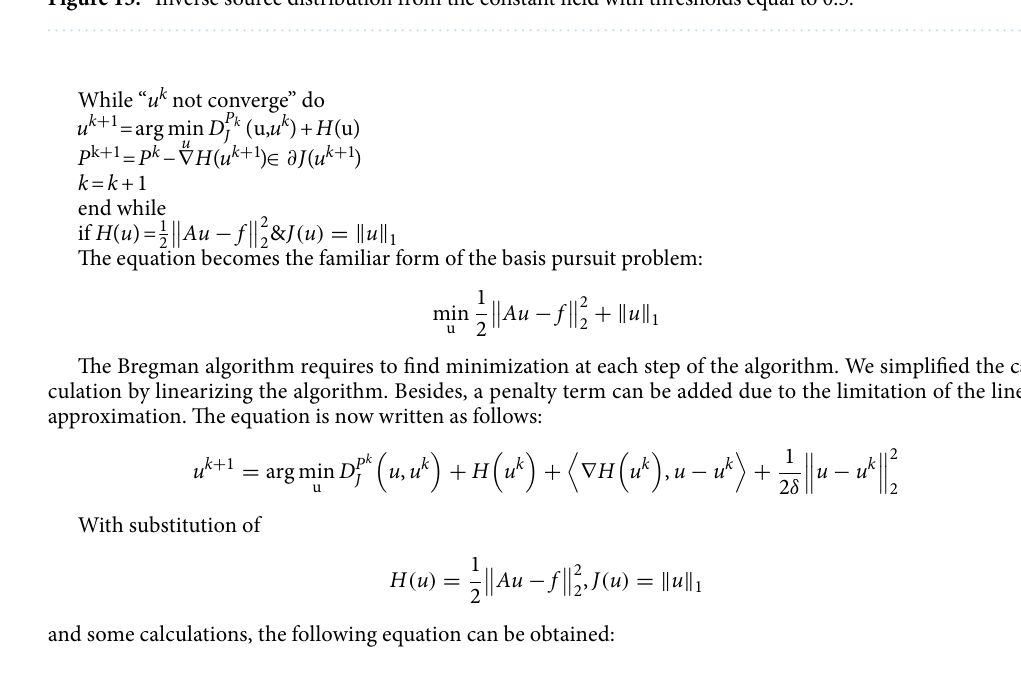
Figure 13. Inverse source distribution from the constant field with thresholds equal to